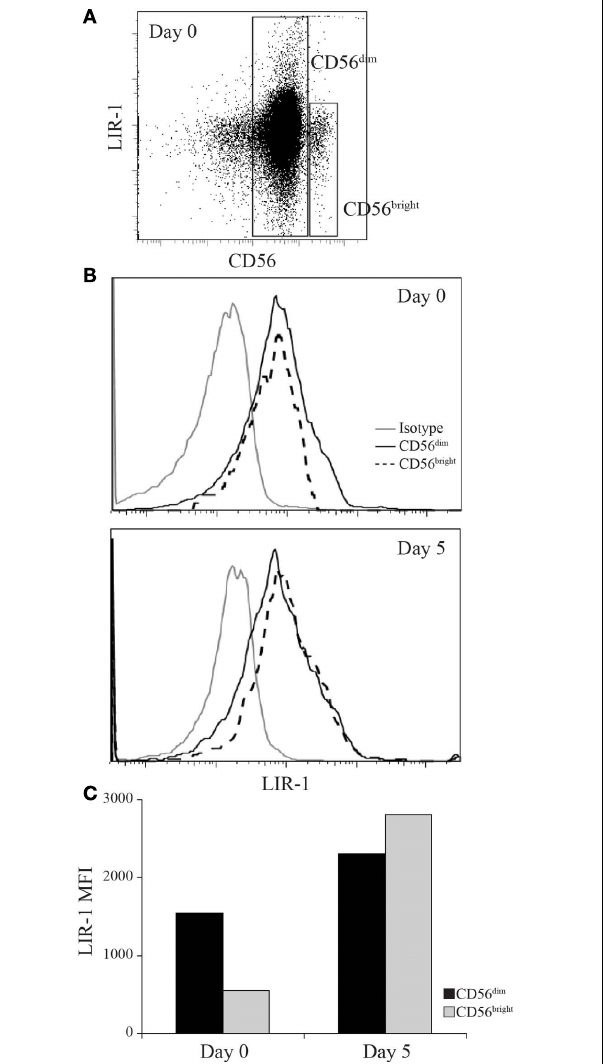
FIGURE 7 | Leukocyte Ig-like receptor 1 expression can be induced on CD56 bright NK to match the profile of CD56 dim NK cells. D231 NK cells were sorted on day 0 into CD56 dim and CD56 bright populations and cultured in IL-2 for 5days. NK cells were provided with fresh IL-2 on day 3. (A) Peripheral blood NK cells were isolated from D231 and examined for CD56 and LIR-1 expression. (B) LIR-1 expression profiles for D231 NK cells as gated in (A) are shown in the upper panel and NK cell LIR-1 expression on both subsets on day 5 are shown in the lower panel. (C) Mean fluorescence intensity of LIR-1 staining from the NK cells shown in (B) . Data is representative of two separate experiments with different